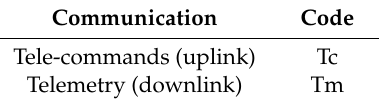
Table 12. TT&C Operations